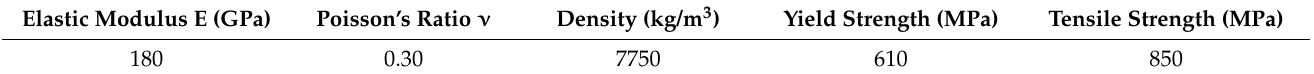
Table 2. Physical characteristics of Cr12MoV hardened steel [26].